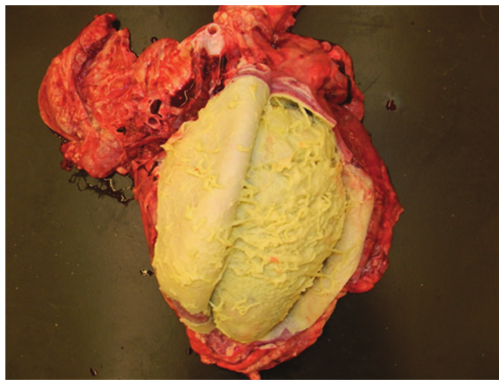
Figure 7: Postmortem image of the heart and pericardial sac, which has been opened. Note that the heart is covered with yellow fibrin.